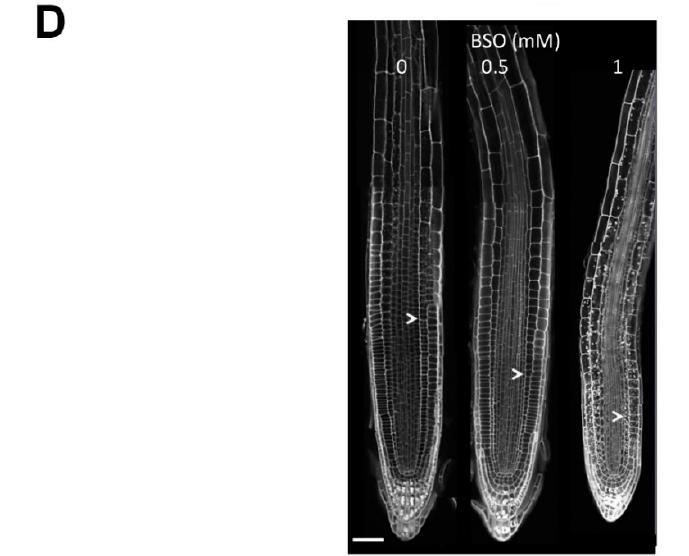
Figure 2. Pharmacological manipulation affecting tripeptide glutathione (GSH) contents and root growth. ( A ) Root length after five days of exposure to different concentration of L-buthionine-(R,S)-sulfoximine (BSO). Error bars represent the means ± SDs ( n = 8–10); ( B ) GSH concentrations in roots of Arabidopsis seedlings after treatments with L-buthionine-(R,S)-sulfoximine (BSO) and BSO plus IAA. Error bars represent the means ± SEs ( n = 3); ( C ) Root length after 5 days of exposure to different concentrations of GSH with and without adjustment of the pH of the growth medium. Error bars represent the means ± SDs ( n = 10–16). Different letters indicate a significant difference at p < 0.05. Fisher’s protected LSD test was used to compare the individual means; ( D ) RAM structure after propidium iodide (PI) staining. White arrows show the end of meristematic zone borders. Scale bar − 50 µm.